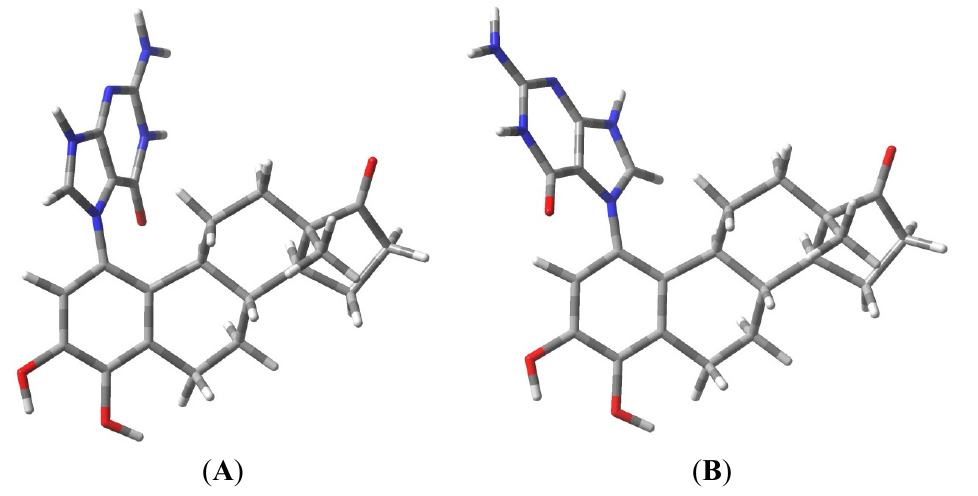
Figure 3. Rotameric forms of the 4-OHE 1 -1-N7Gua estrogen-DNA adduct. ( A ) The α -isomer with purine ring system pointed away from the viewer; ( B ) The β -isomer with purine ring system pointed towards the